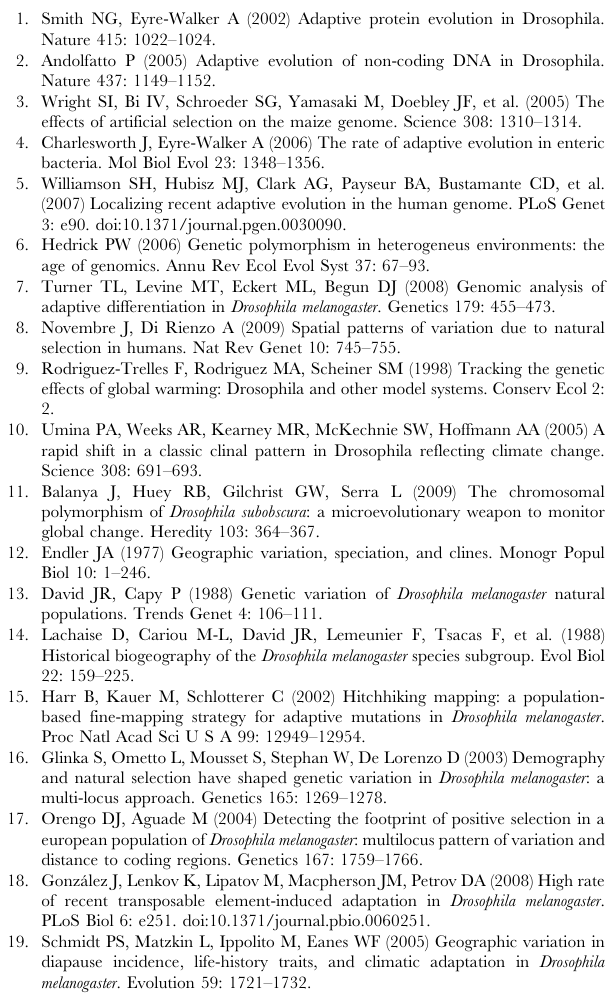
Table S3 Population frequencies of the five TEs analyzed in the four populations collected along the Australian cline.